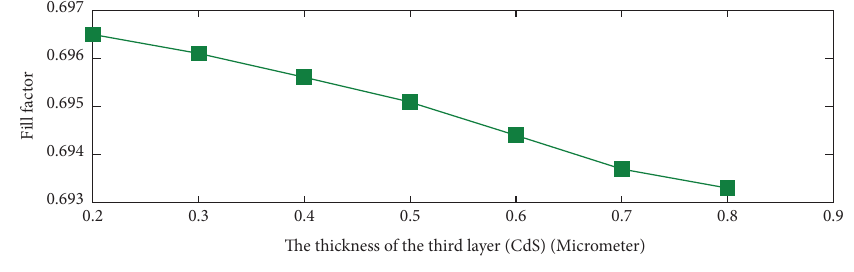
Figure 5: Graph of the flling factor according to the thickness of the CdS layer.